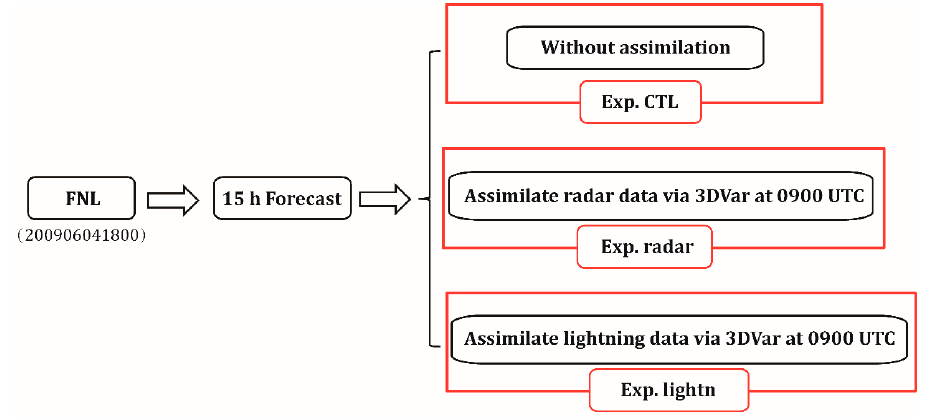
Figure 1. Flow chart of designed experiments.